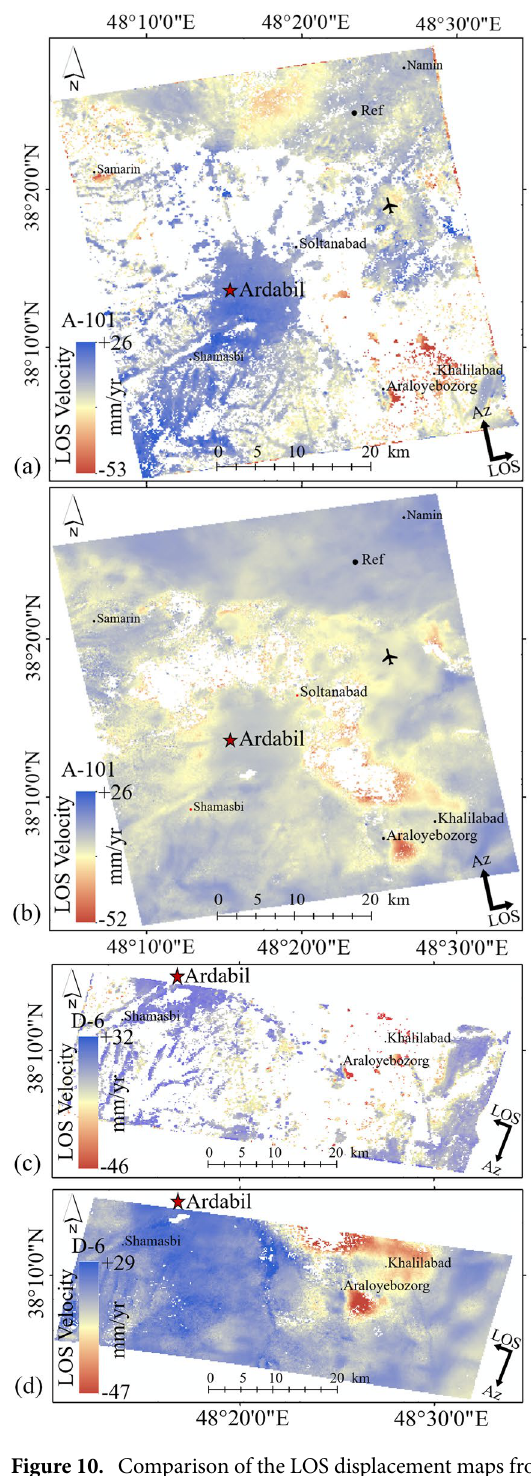
Figure 10. Comparison of the LOS displacement maps from S1A images (March 2017 to January 2019) for A-101 track using ( a ) GMTSAR, ( b ) LiCSBAS, and for D-6 track using ( c ) GMTSAR and ( d ) LiCSBAS. This figure was created using the QGIS version 3.14.0-Pi software (https:// qgis. org/ en/